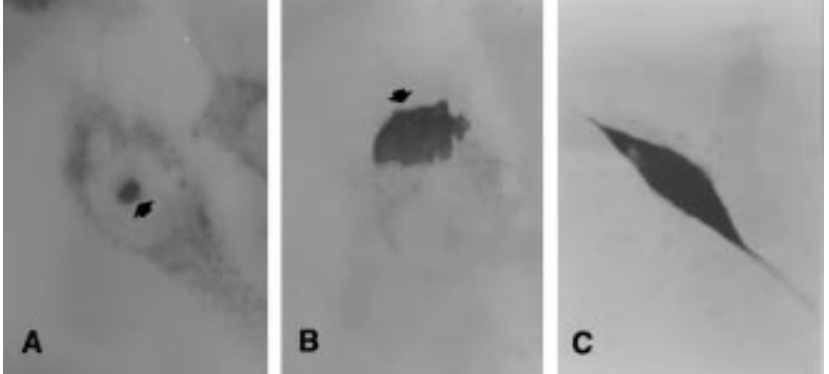
Fig. 6. Immunocytochemical staining of HT-1080 cells for LRP protein (blue colour). A – outline of a micronucleus in the macronucleus. B – microcell is still associated with the macrocell. C – microcell in intercellular space. Arrows point to developing microcells. Obj. 90 (cid:2) , oc. 7 (cid:2) .